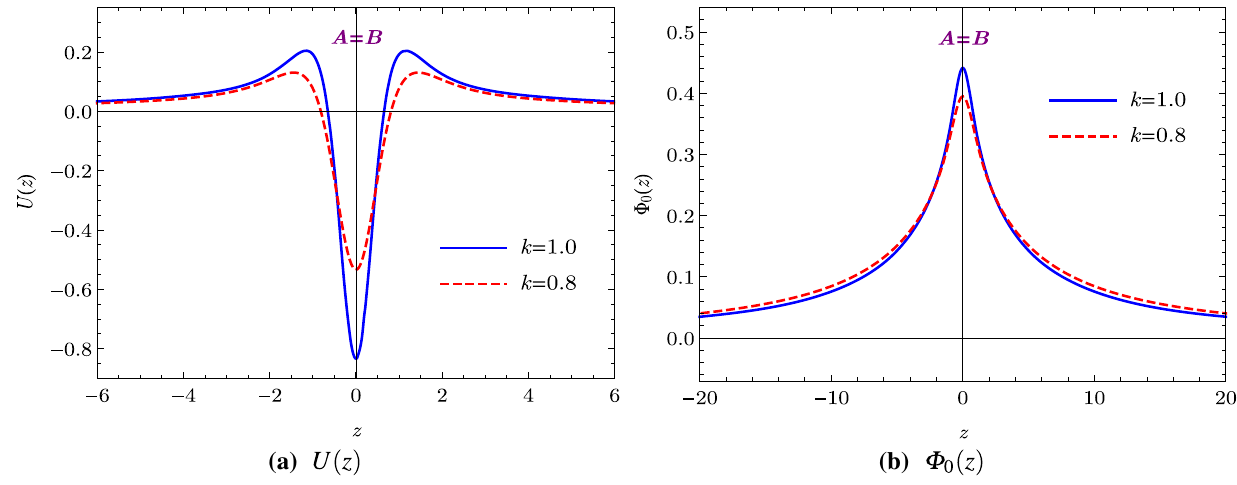
Fig. 4 The profiles of the effective potential U ( z ) and gravitational zero mode (cid:19) 0 ( z ) for the case of A = B